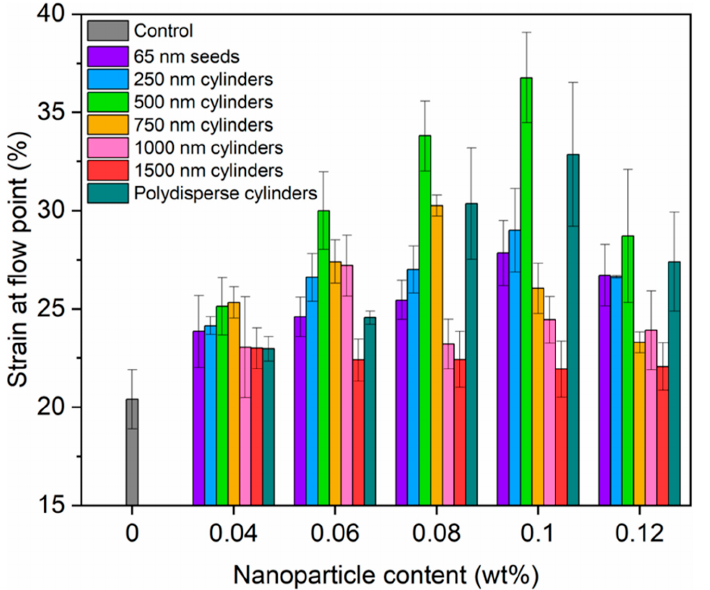
Figure 2. Histogram comparing the strain values at the flow point for nanocomposite hydrogels incorporating cylindrical micelles at different wt %. Error bars represent the standard deviation of the data.